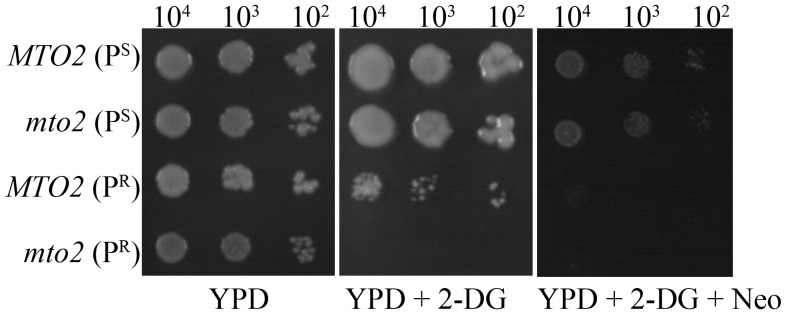
Properties of yeast cells on YPD plate in the presence of glycolytic inhibitor 2-Deoxy-D-glucose (2-DG).Series dilutions of each strain were spotted on medium and the plate was incubated at 30°C for 72 hours. A, on YPD medium. B, on YPD medium supplemented with 2.5 mM 2-DG. C, on YPD medium supplemented with 2.5 mM 2-DG and 300 µg/ml neomyocin.